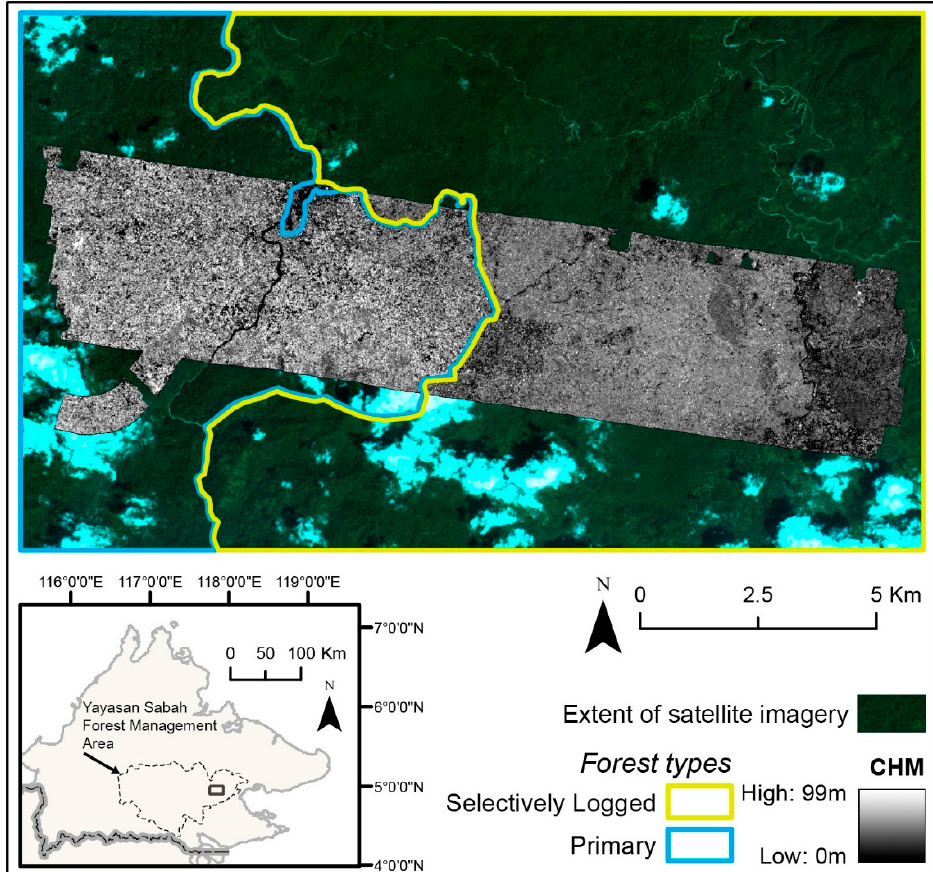
Figure 1. Location of the study area in Sabah, Malaysia, showing the extent of the air- and space-borne remotely sensed imagery across a primary and selectively logged tropical forest.